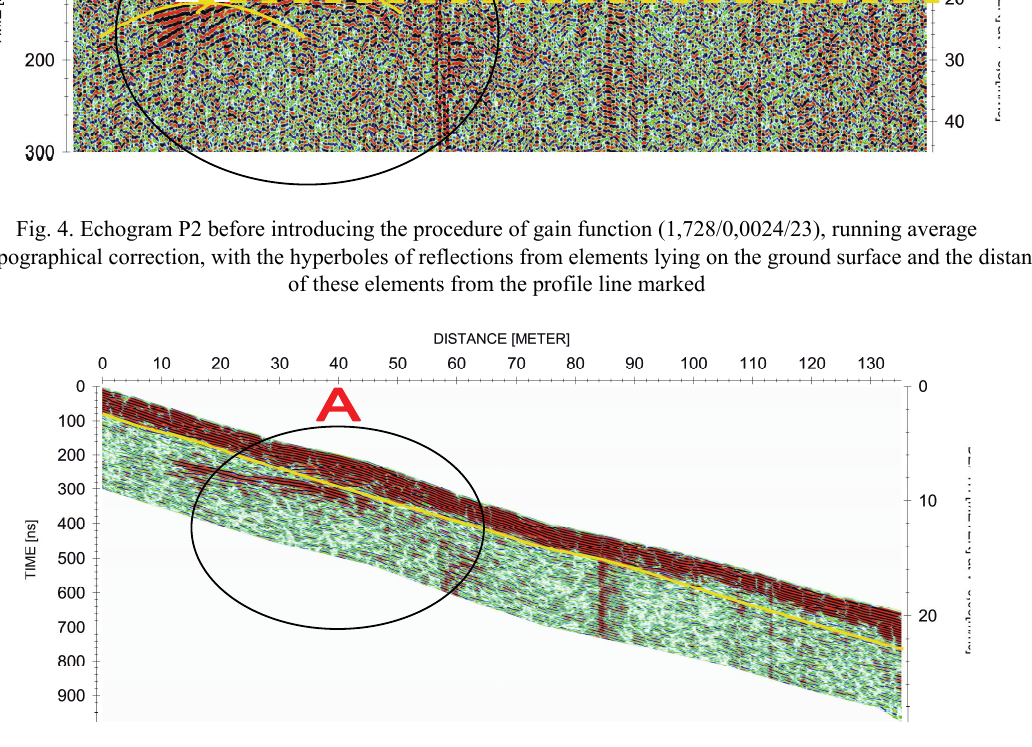
Fig. 5 Echogram P2 with a line of the maximum range considered equivalent to the slide